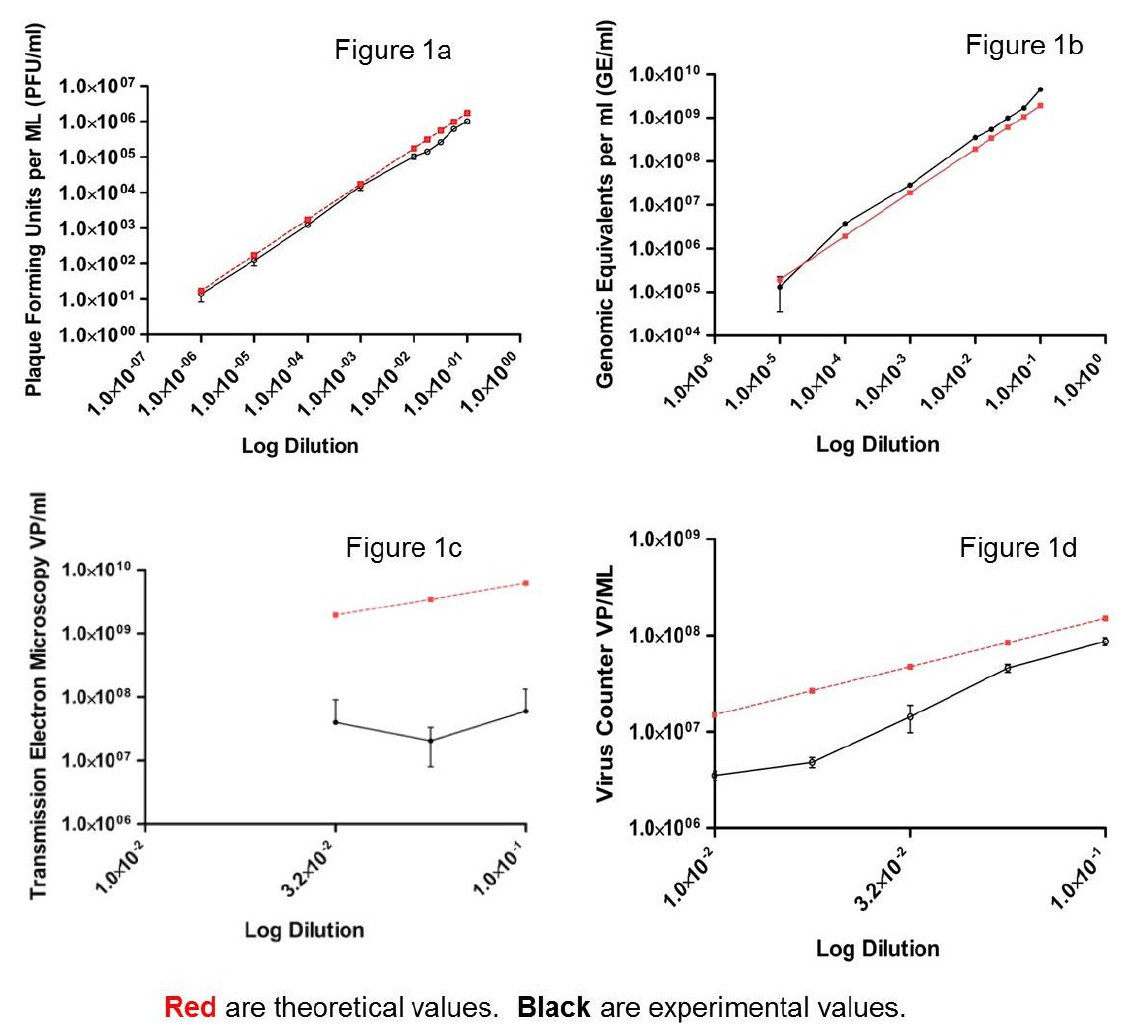
Figure 1. Log-log plot of dilution versus concentration for a series of Ebola virus (EBOV), Kikwit variant, samples produced by diluting the stock virus. Theoretical results are shown in red and are based on the original stock concentration determined at time of preparation. Experimental results are shown in black. ( a ) Infectious virus was quantified for each sample using six well plates of confluent Vero E-6 cells and an agarose-based plaque assay (PFU/mL). All samples were tested in six replicates; bars represent standard deviation. ( b ) Genomic equivalents were quantified for each sample using an EBOV-specific qRT-PCR (GE/mL). All samples were tested in triplicate; bars represent standard deviation. ( c ) Virus particle concentration (VP/mL) was quantified from each sample using transmission electron microscopy (TEM). All samples were tested in triplicate. Bars represent standard deviation. ( d ) Virus particle concentration was quantified for each sample using the ViroCyt ® Virus Counter 2100 instrument. All samples were tested in triplicate; bars represent standard